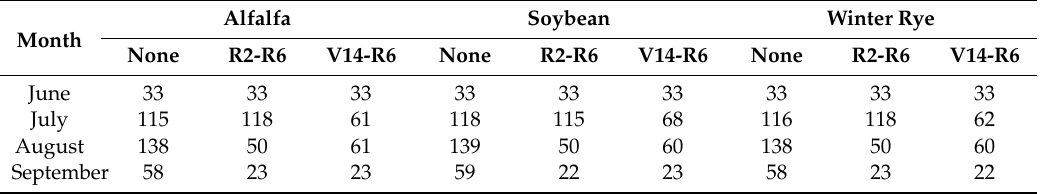
Figure 1. Daily precipitation (Precip), irrigation (Irrig), estimated soil water storage (Storage), and estimated crop evapotranspiration (ET c ) from maize emergence (day 151) to maize physiological maturity (R6, day 267) for treatments with no drought stress (None), drought stress from the 14 leaf collar maize phenological stage (V14) to R6 (V14-R6), and drought stress from the blister maize phenological stage (R2) to R6 (R2-R6) that received the optimal nitrogen rate, averaged across experiments. In the experiment where the previous crop was soybean, the values for soil water storage are from all combinations of three drought stress treatments and both hybrids (standard and drought tolerant). In the experiments where the previous crop was alfalfa and winter rye, the values for soil water storage are from three drought stress treatments with the drought-tolerant hybrid, and the treatment with drought stress from V14 to R6 with the standard hybrid. Table 3. Total monthly irrigation (mm) for treatments with no drought stress (None), drought stress from the blister maize phenological stage (R2) to maize physiological maturity (R6) (R2-R6), and drought stress from the 14 leaf collar maize phenological stage (V14) to R6 (V14-R6) for experiments where maize followed alfalfa, soybean, and winter rye.